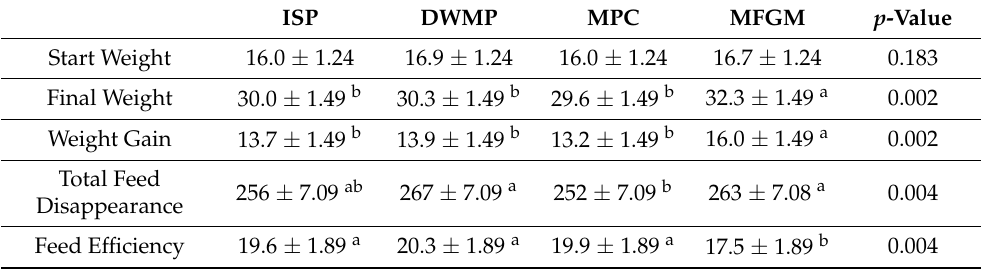
Table 2. Animal Growth and Feed